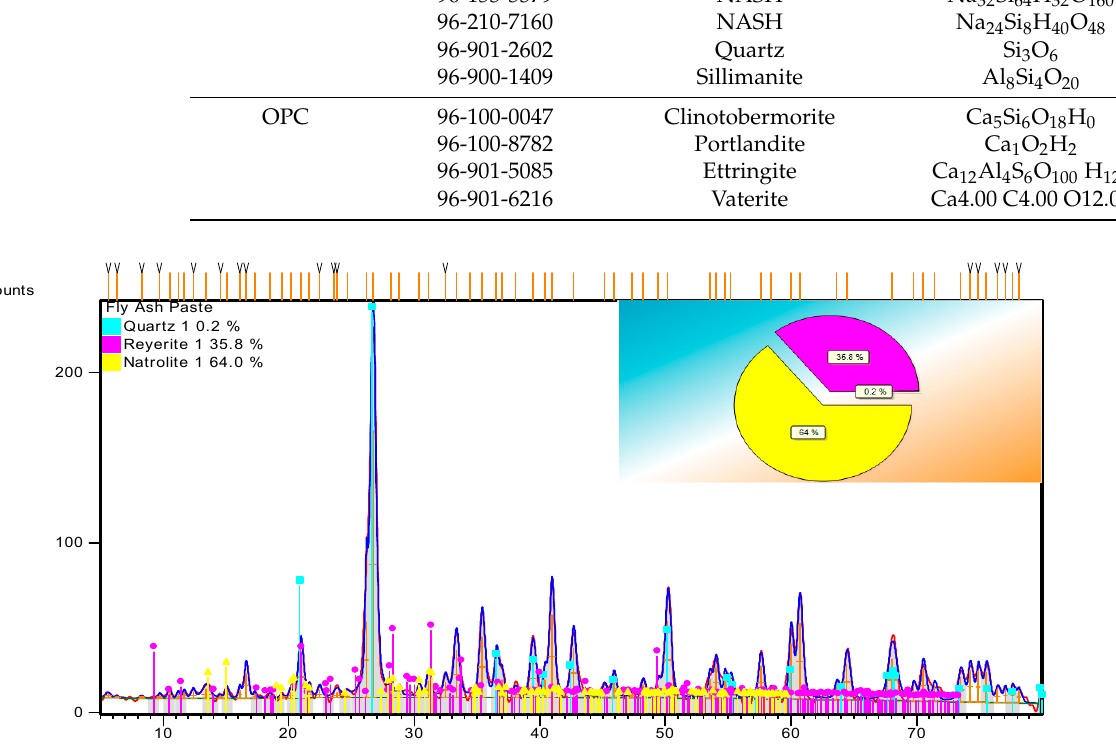
Figure 15. XRD of Fly ash paste at 7 days of ambient curing.